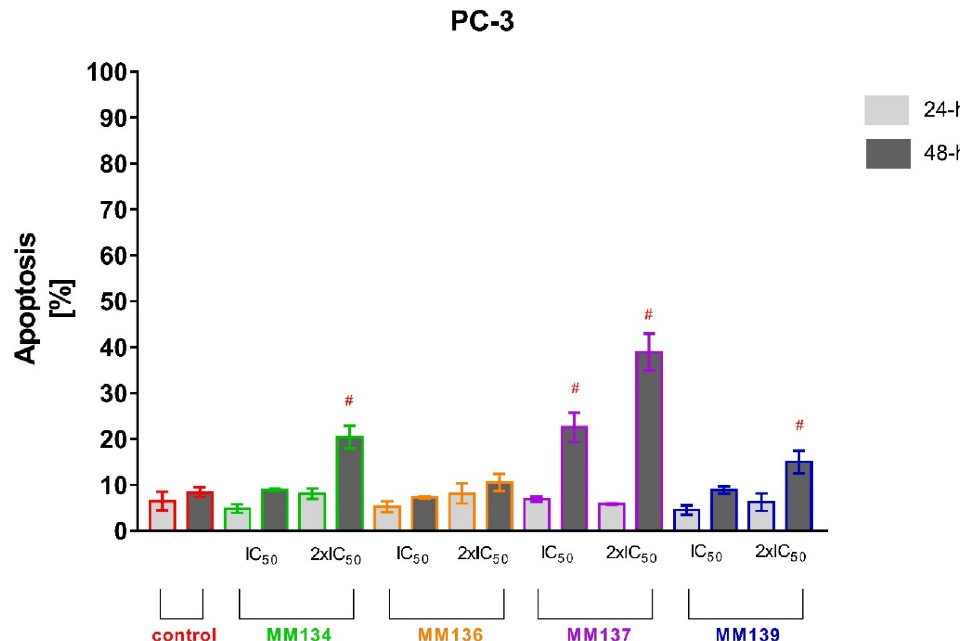
Figure 7. Determination of apoptosis induction in PC-3 cell line treated with IC 50 and 2xIC 50 concentrations of MM-compounds measured with Annexin V FITC following 24 and 48 h incubation time. Data are presented as mean percentage of apoptotic cells (early and late apoptotic) ± SD values. The differences between the experimental samples and vehicle control were evaluated by the ANOVA test followed by Tukey’s test ( p < 0.05). # significant difference compared to the negative control (48 h incubation time); p < 0.05; N = 1 × 104.